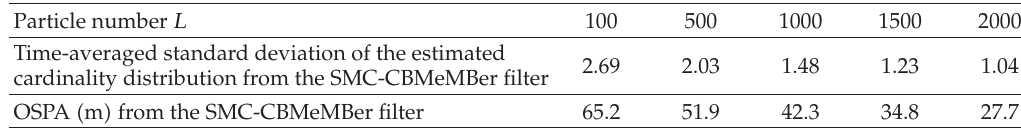
Table 1: Time-averaged standard deviation of the estimated cardinality distribution and time-averaged OSPA (cid:2) m (cid:3) in various L . Particle number L 100 500 1000 1500 2000 Time-averaged standard deviation of the estimated 2.69 2.03 1.48 1.23 1.04 cardinality distribution from the SMC-CBMeMBer filter OSPA (cid:2) m (cid:3) from the SMC-CBMeMBer filter